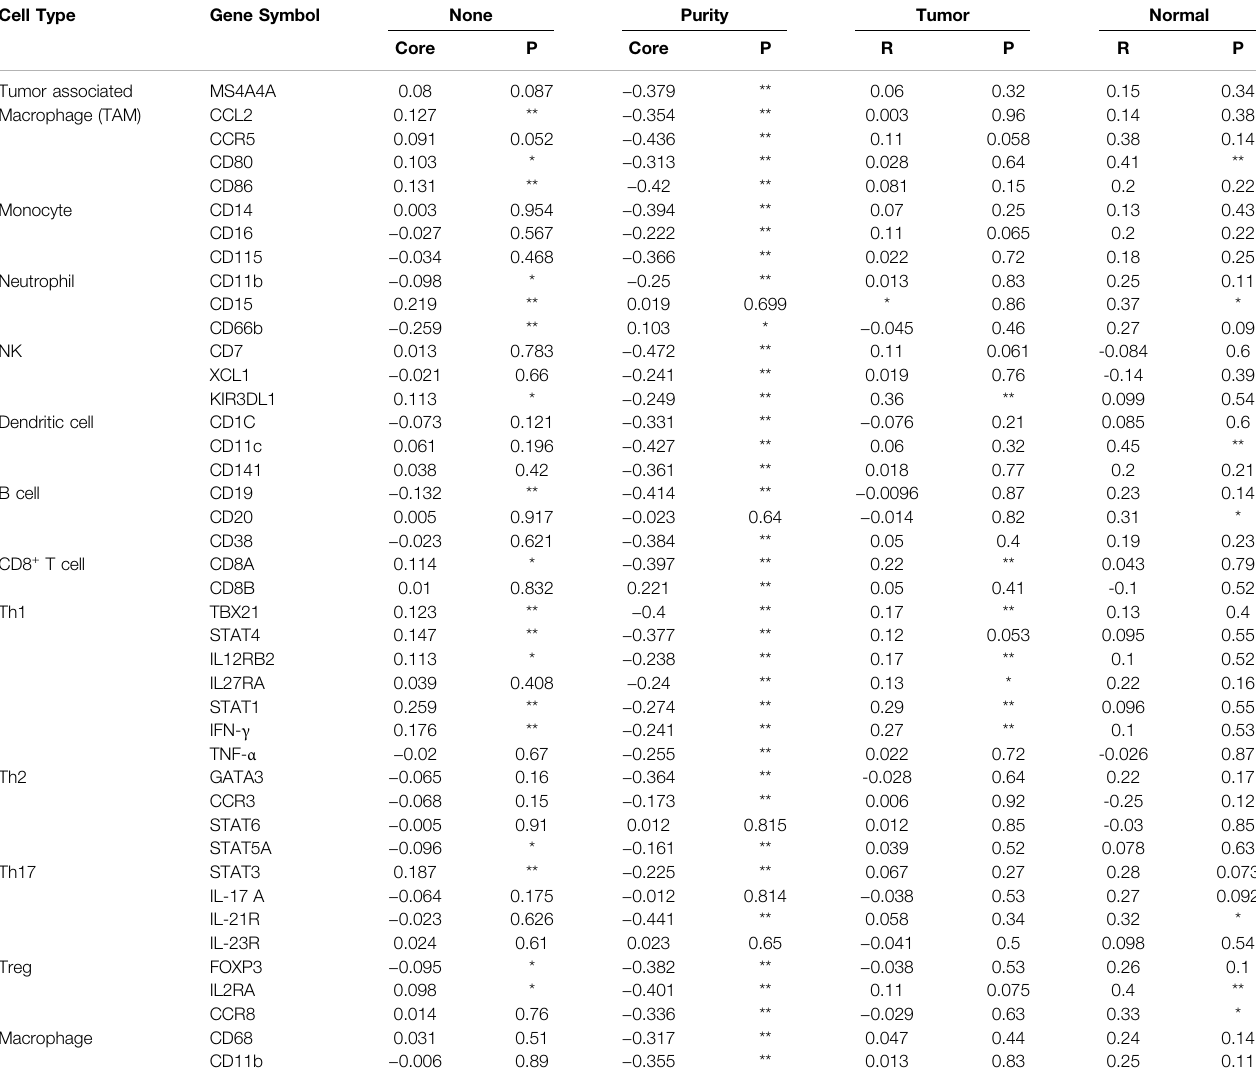
TABLE 2 | Correlation analysis between SLC7A11 and immune cell markers in TIMER and GEPIA. Cell Type Gene Symbol None Purity Tumor Normal